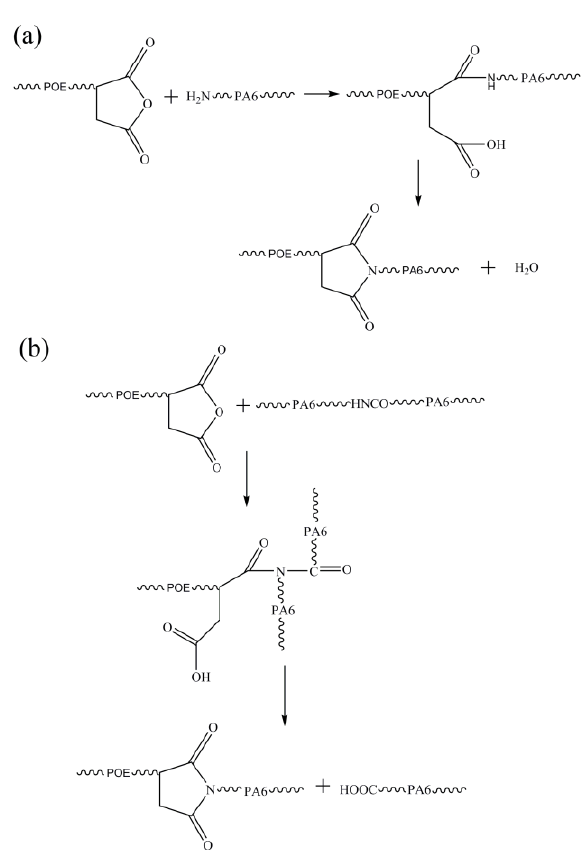
Figure 3. Possible chemical reaction between PA6 and POE-g-MAH. ( a ) the reaction between MAH groups of POE-g-MAH and –NH 2 groups of PA6; ( b ) the reaction between MAH groups of POE-g-MAH and –NH– groups of PA6.